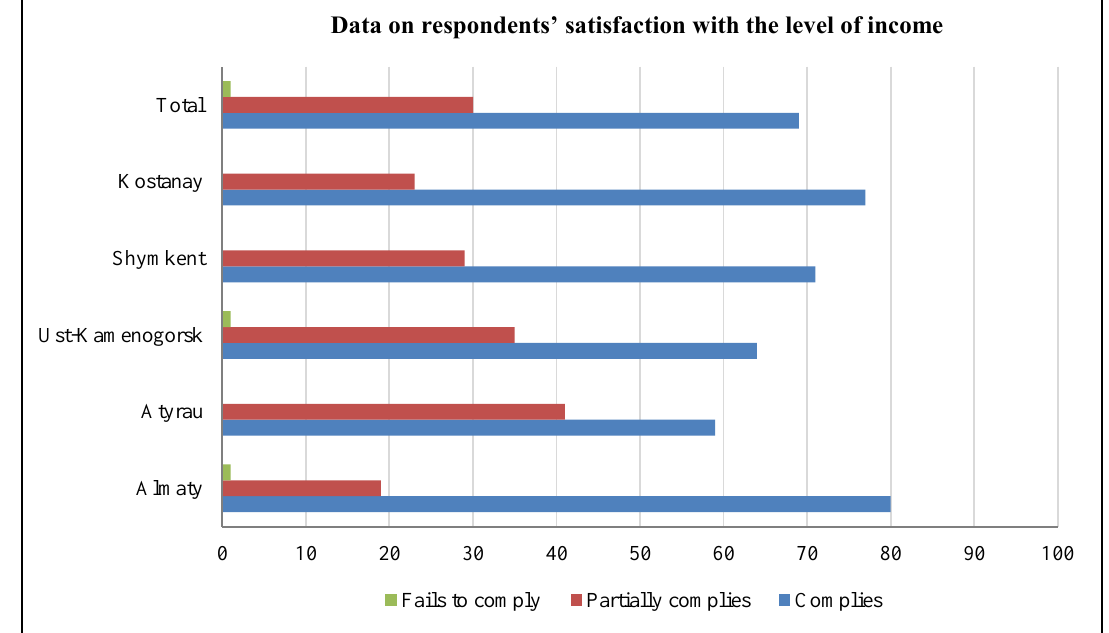
Figure 5. Data on respondents’ satisfaction with the level of